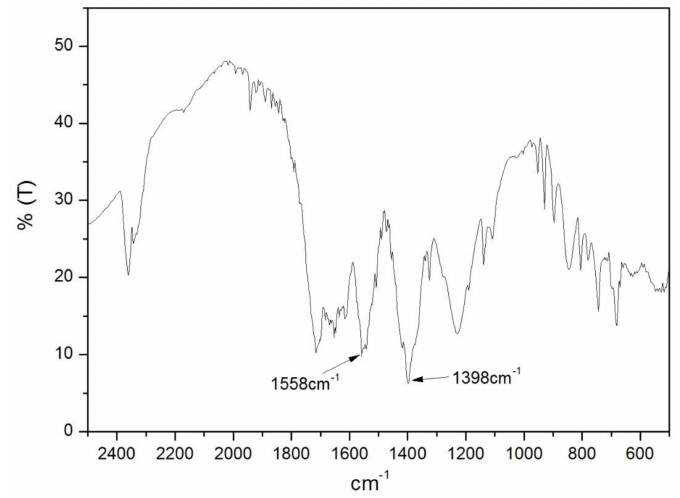
Figure 5. IR spectra of Fe-MOFs.